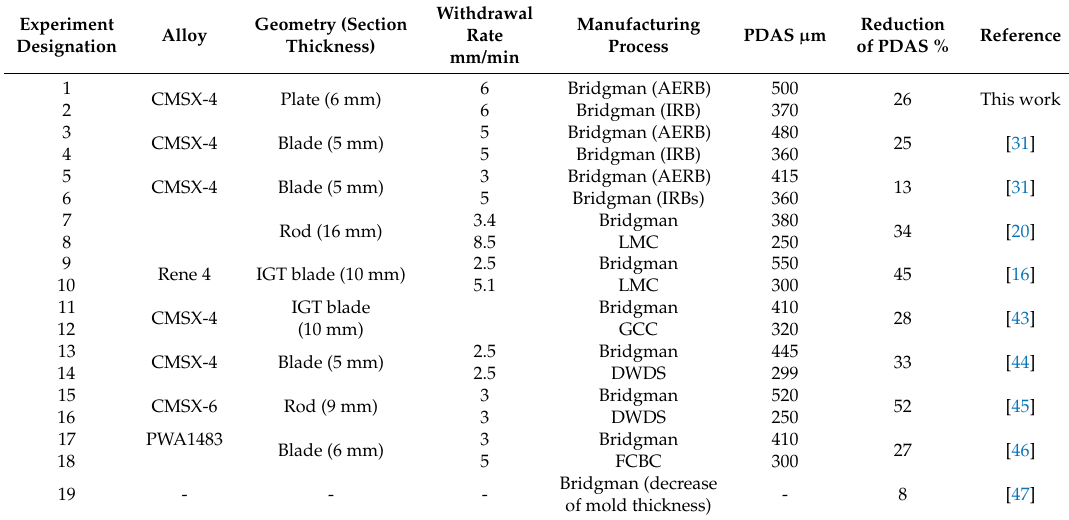
Table 2. Percentage reduction of primary dendrite arm spacing (PDAS) in casting for different manufacturing processes and solidification